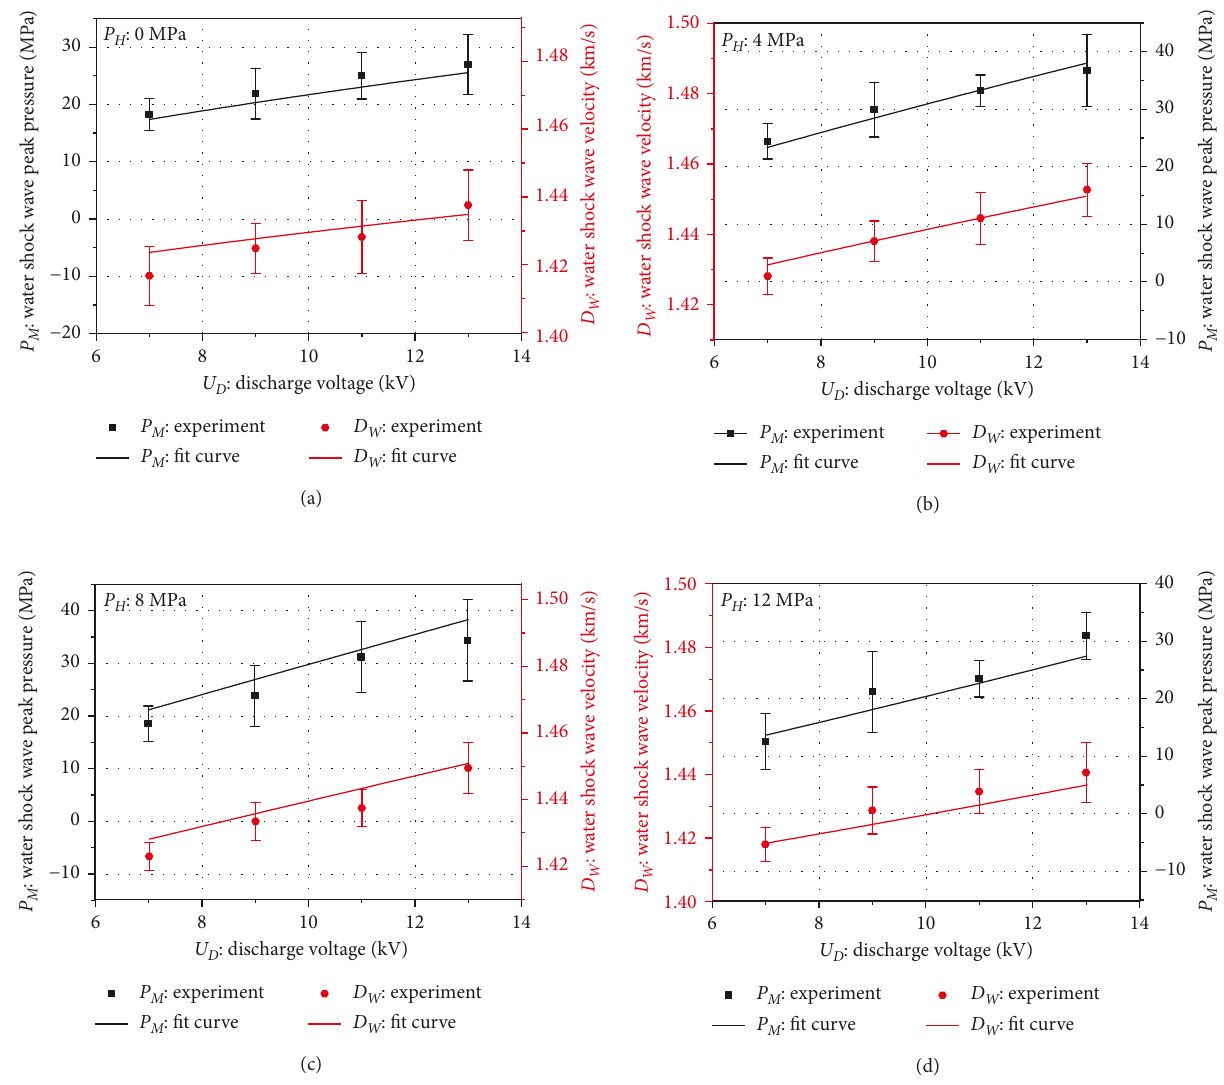
Figure 7: Variations between U D , P M , and velocity D W under four different P H settings: (a) 0 MPa, (b) 4 MPa, (c) 8MPa, and (d)